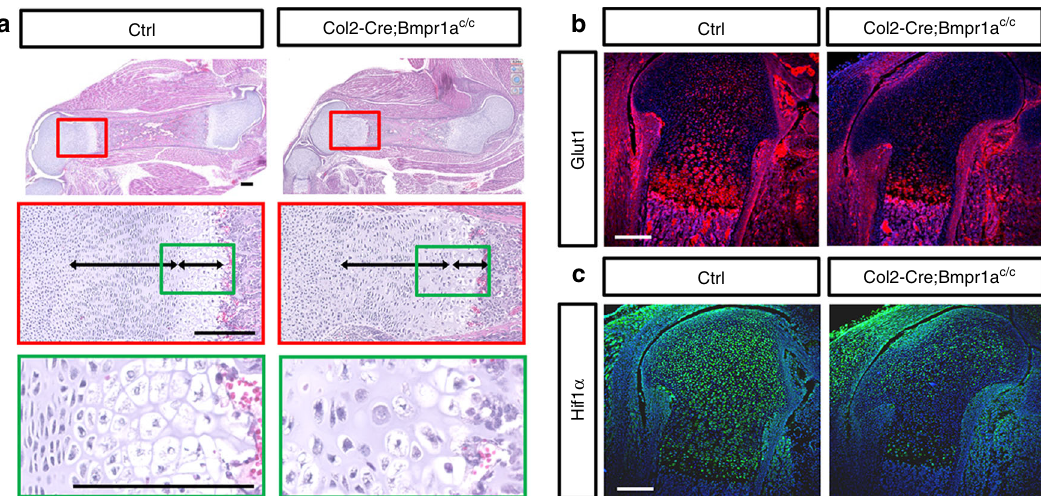
Fig. 7 Deletion of Bmpr1a with Col2-Cre disrupts chondrocyte maturation and reduces Glut1 expression. a Representative H&E staining of the femur from normal (Ctrl) versus Col2-Cre; Bmpr1a f/f littermate embryos at E18.5. Boxed areas shown at high magni fi cation below. b , c Immuno fl uorescence staining of Glut1 ( b ) or Hif1a ( c ) in the femur at E18.5. Three littermate pairs were analyzed with similar results. Scale bar: 200 µ m. Each image is representative